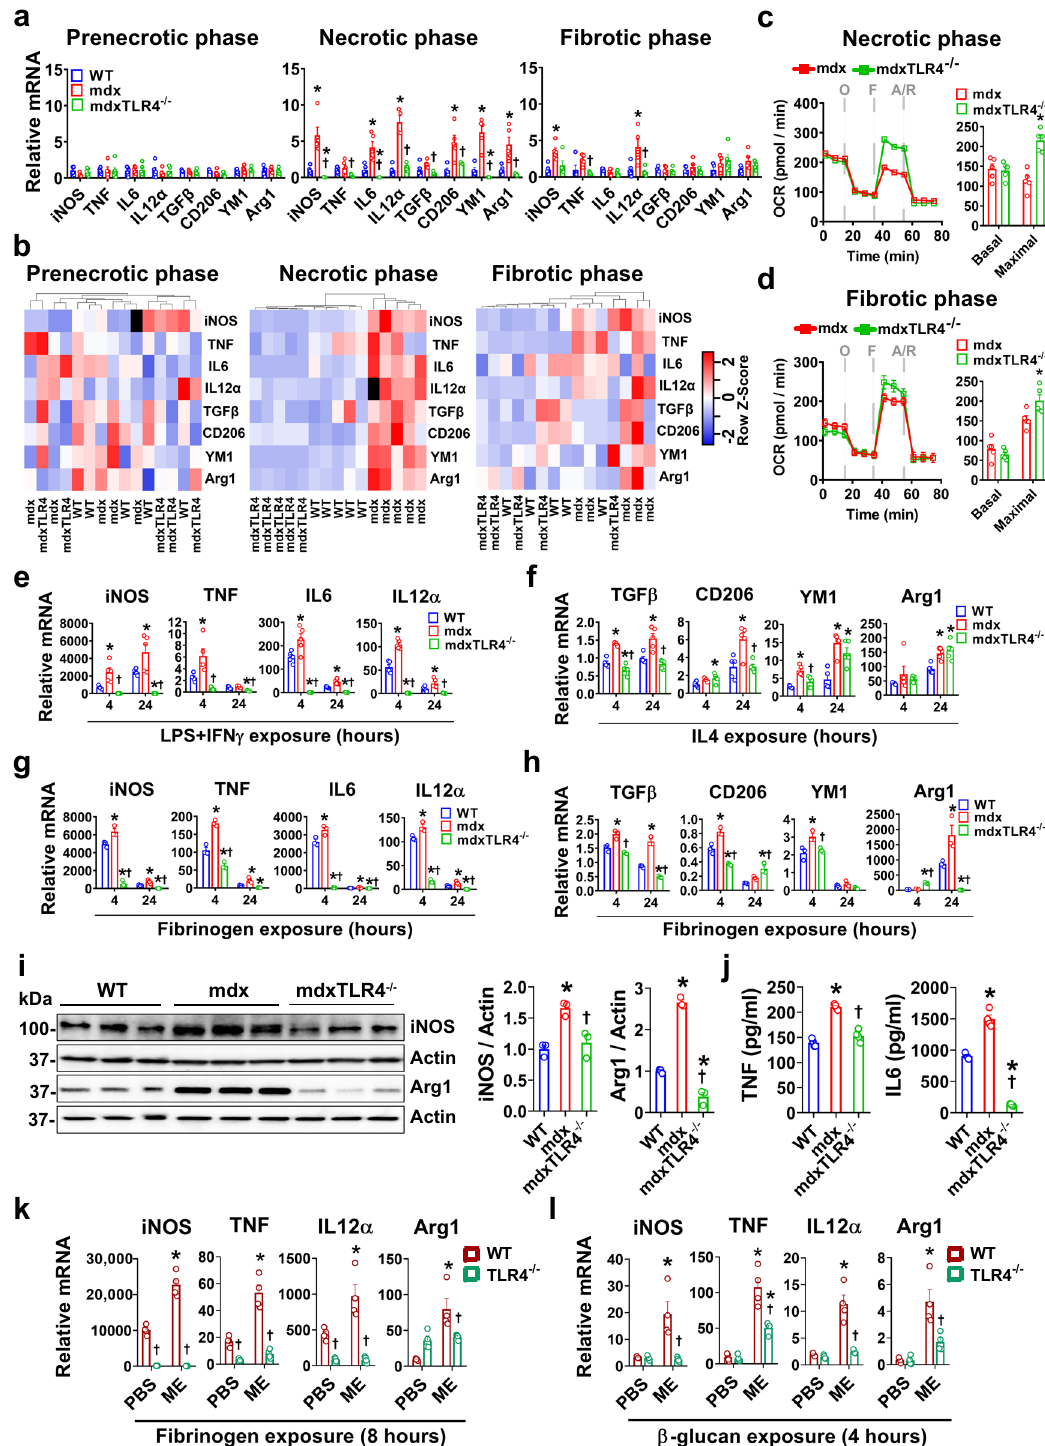
(Supplementary Fig. 8d), which is consistent with the trained immunity phenotype. Transcription factor-related pathway analysis was also performed (Supplementary Fig. 9; Supplemen- tary Data 4 and 5 tables), and the corresponding peak patterns suggested possible involvement of interleukin, Notch, and interferon